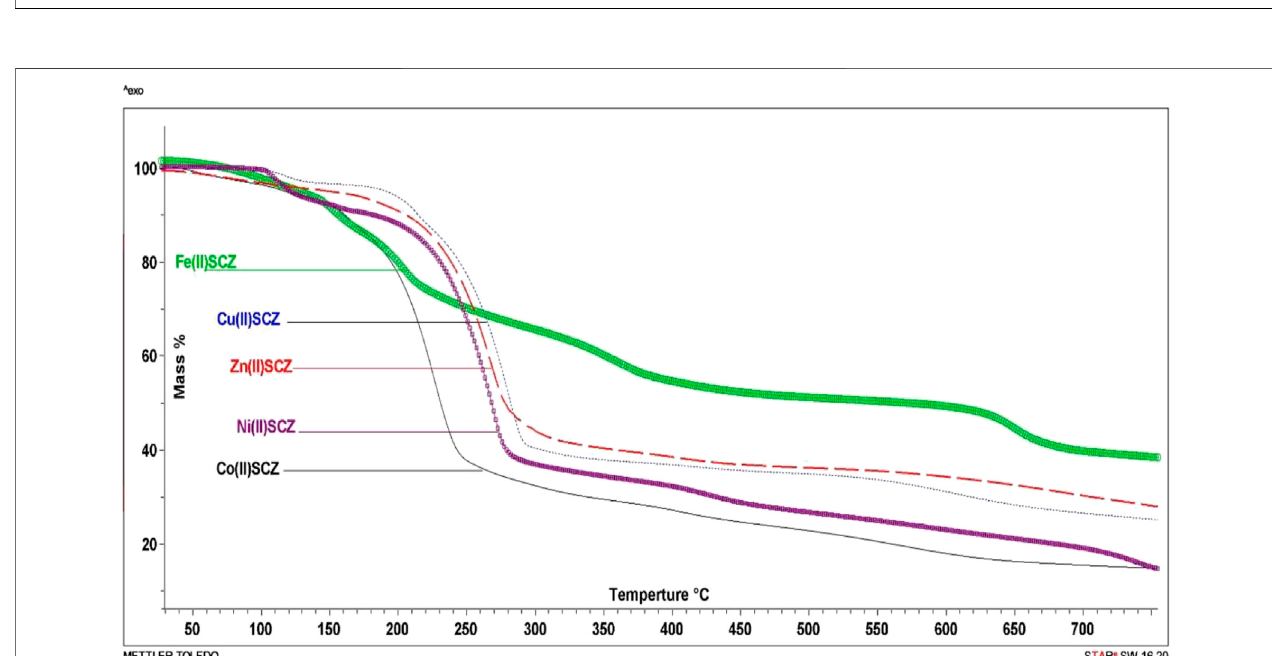
FIGURE 3 | TG curves of [Cu(SCZ) 2 Cl]Cl.2H 2 O, [Co(SCZ) 2 ClOH 2 ]Cl.2H 2 O, [Ni(SCZ) 2 Cl 2 ].2H 2 O, [Zn(SCZ) 2 ]Cl 2 .2H 2 O, and [Fe(SCZ) 2 Cl 2 ].2H 2 O